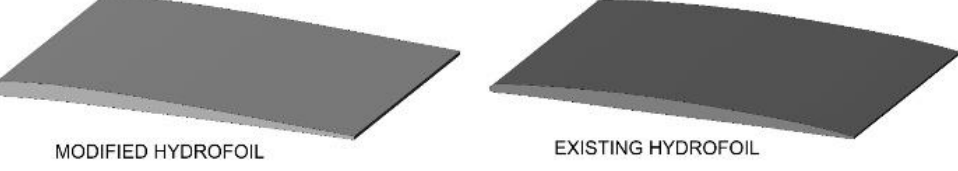
Figure 4. Hydrofoils used in the cavitation tunnel analysis.